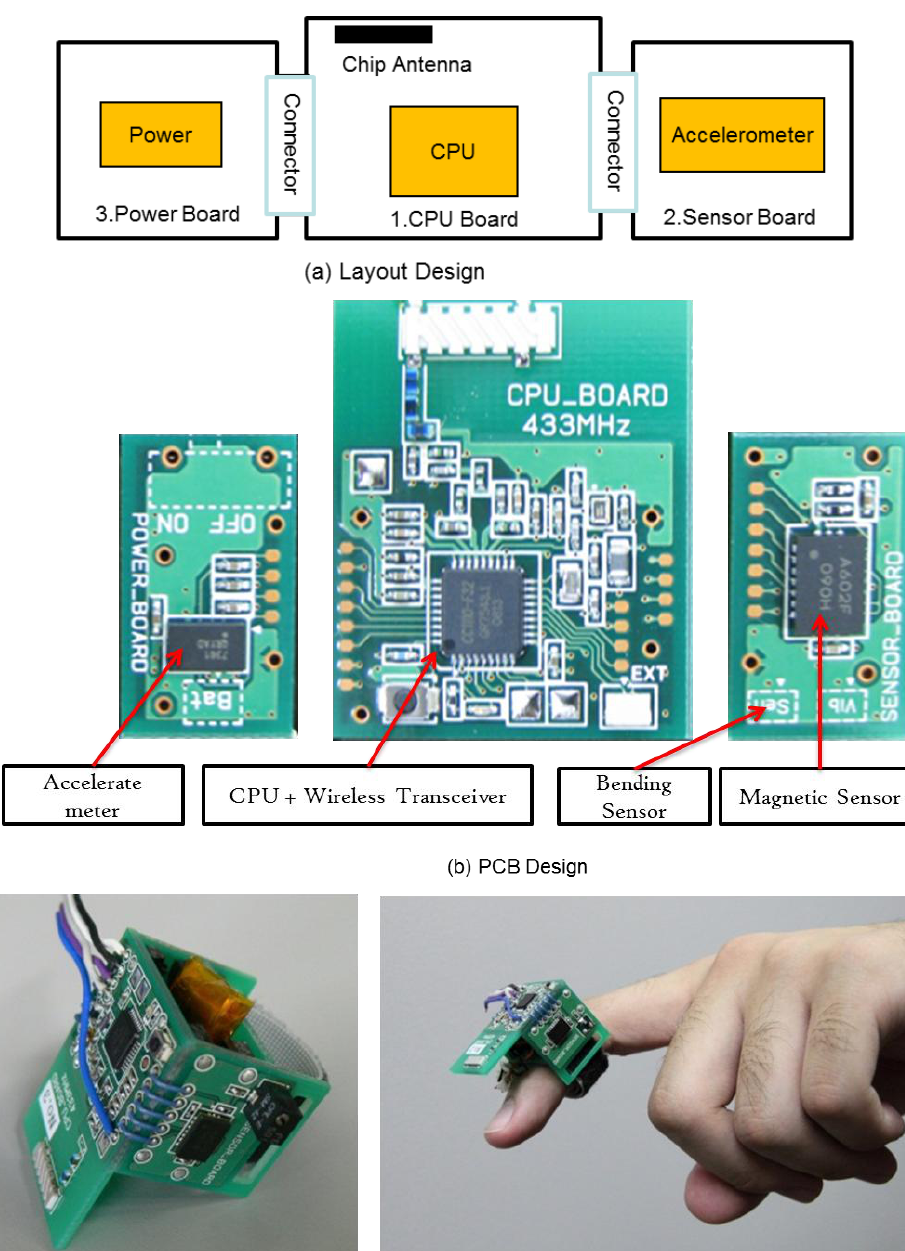
Figure 4. Magic ring: wearable sensing device for finger gesture